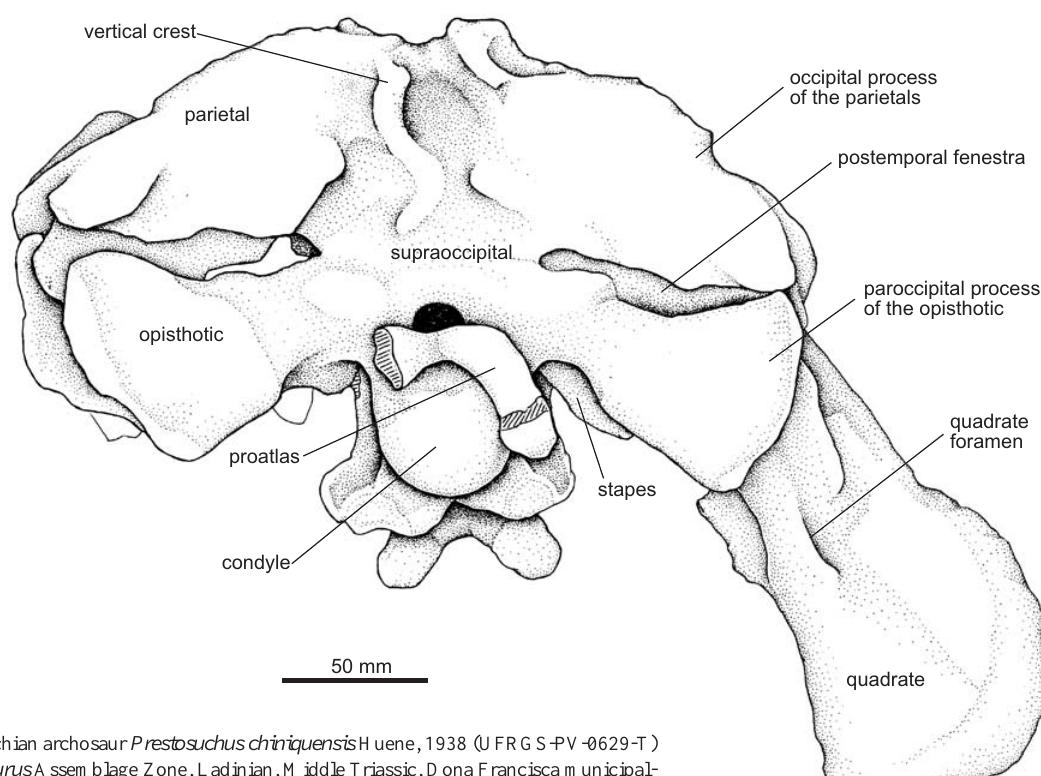
Fig. 12. The pseudosuchian archosaur Prestosuchus chiniquensis Huene, 1938 (UFRGS-PV-0629-T) from the Dinodontosaurus Assemblage Zone, Ladinian, Middle Triassic, Dona Francisca municipal- ity, Rio Grande do Sul State, Brazil; explanatory drawing of the skull in occipital